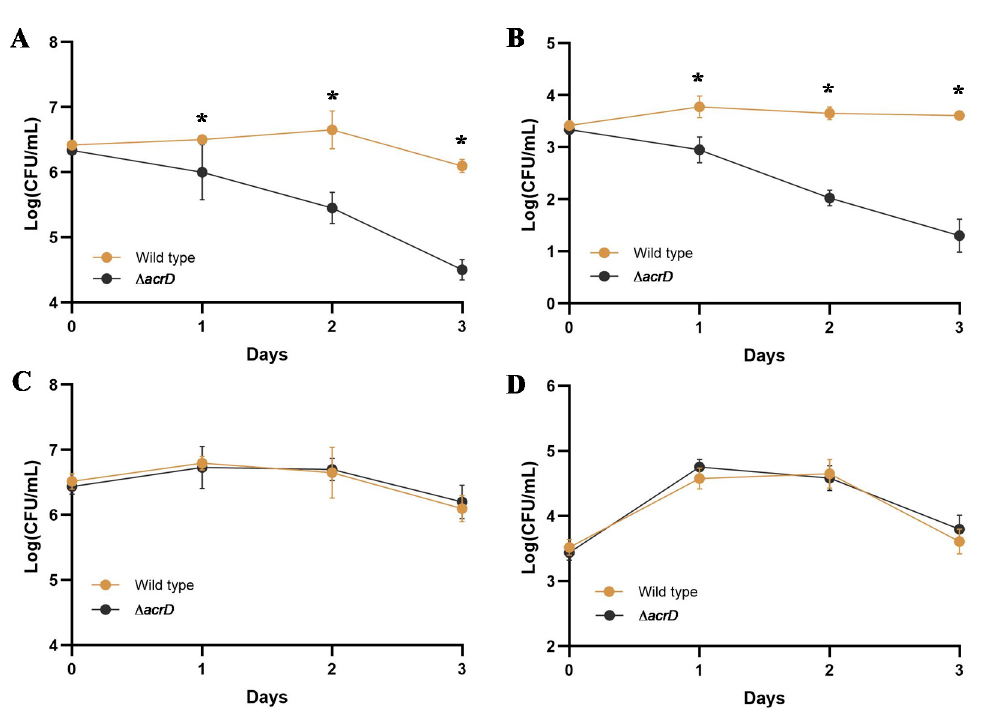
Figure 2. Survival ability of S . Enteritidis wild type and Δ acrD mutant in whole egg white ( A , B ) and its filtrate ( C , D ). Survival of S . Enteritidis in whole egg white with initial concentrations of 10 6 CFU/mL ( A ) and 10 3 CFU/mL ( B ). Survival of S . Enteritidis in egg white filtrate with initial concentrations of 10 6 CFU/mL ( C ) and 10 3 CFU/mL ( D ). Three independent experiments were performed, and the results of representative experiments were shown. Error bars indicate the standard deviation of three replicates. Asterisks (*) indicate significant differences in the survival ability between wild type and Δ acrD mutants ( p < 0.05).